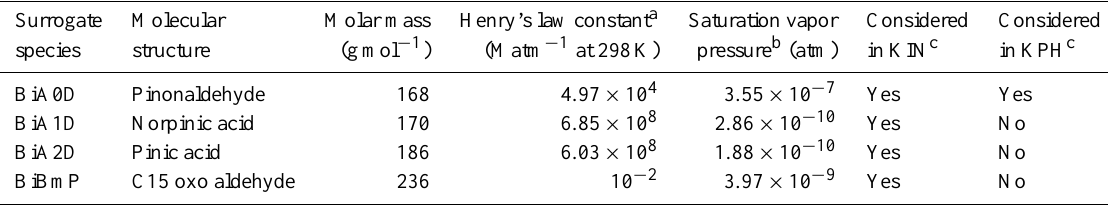
Table 1. Properties of the biogenic hydrophilic and hydrophobic surrogate SOA species used in the simulations conducted with the CHIMERE model. Surrogate Molecular Molar mass Henry’s law constant a Saturation vapor Considered Considered species